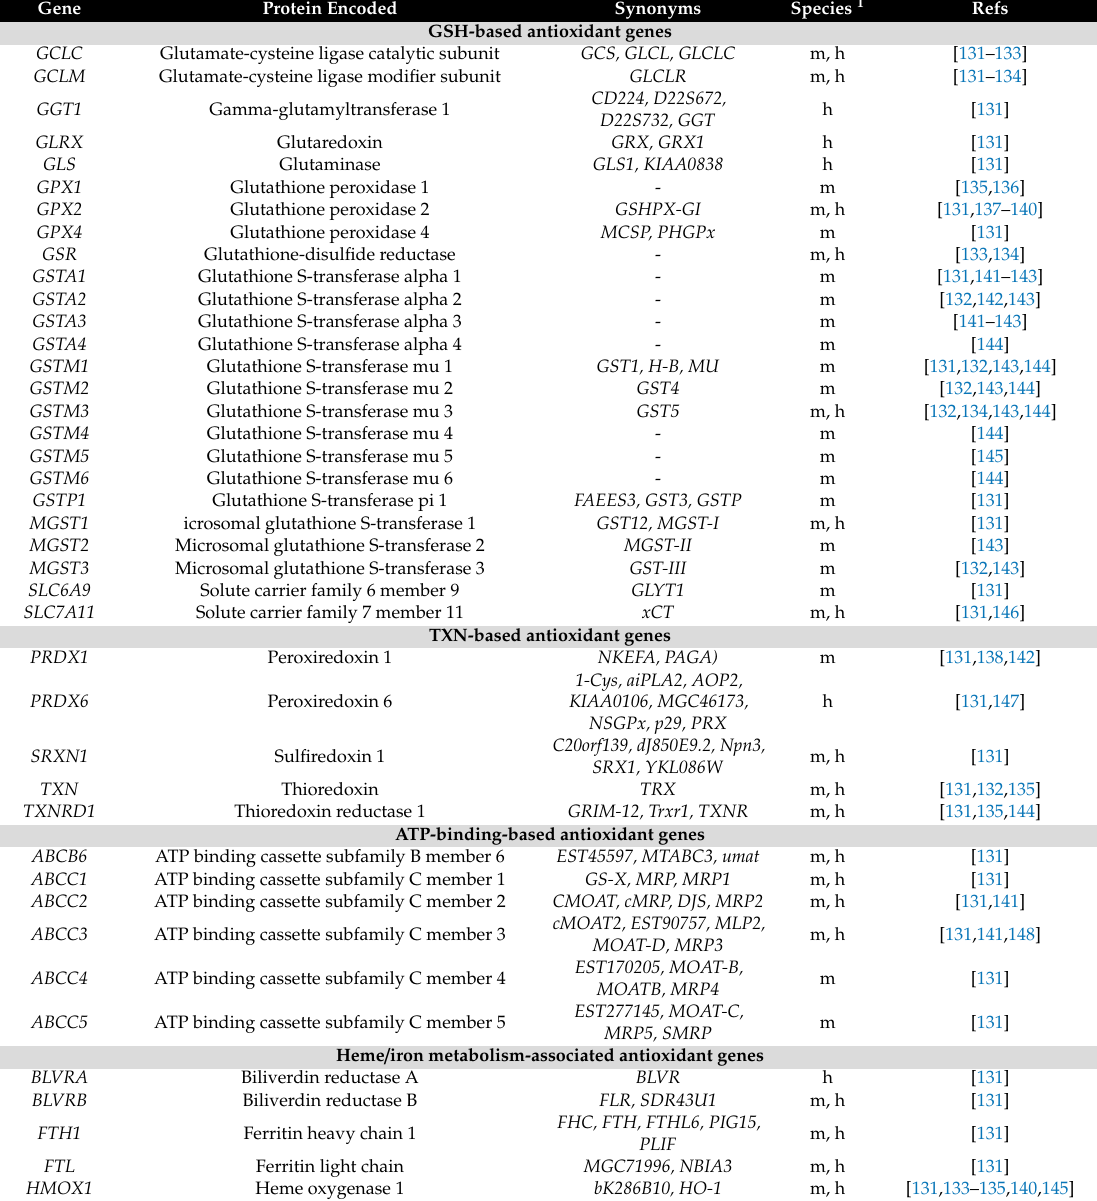
Table 1. Antioxidant genes regulated by